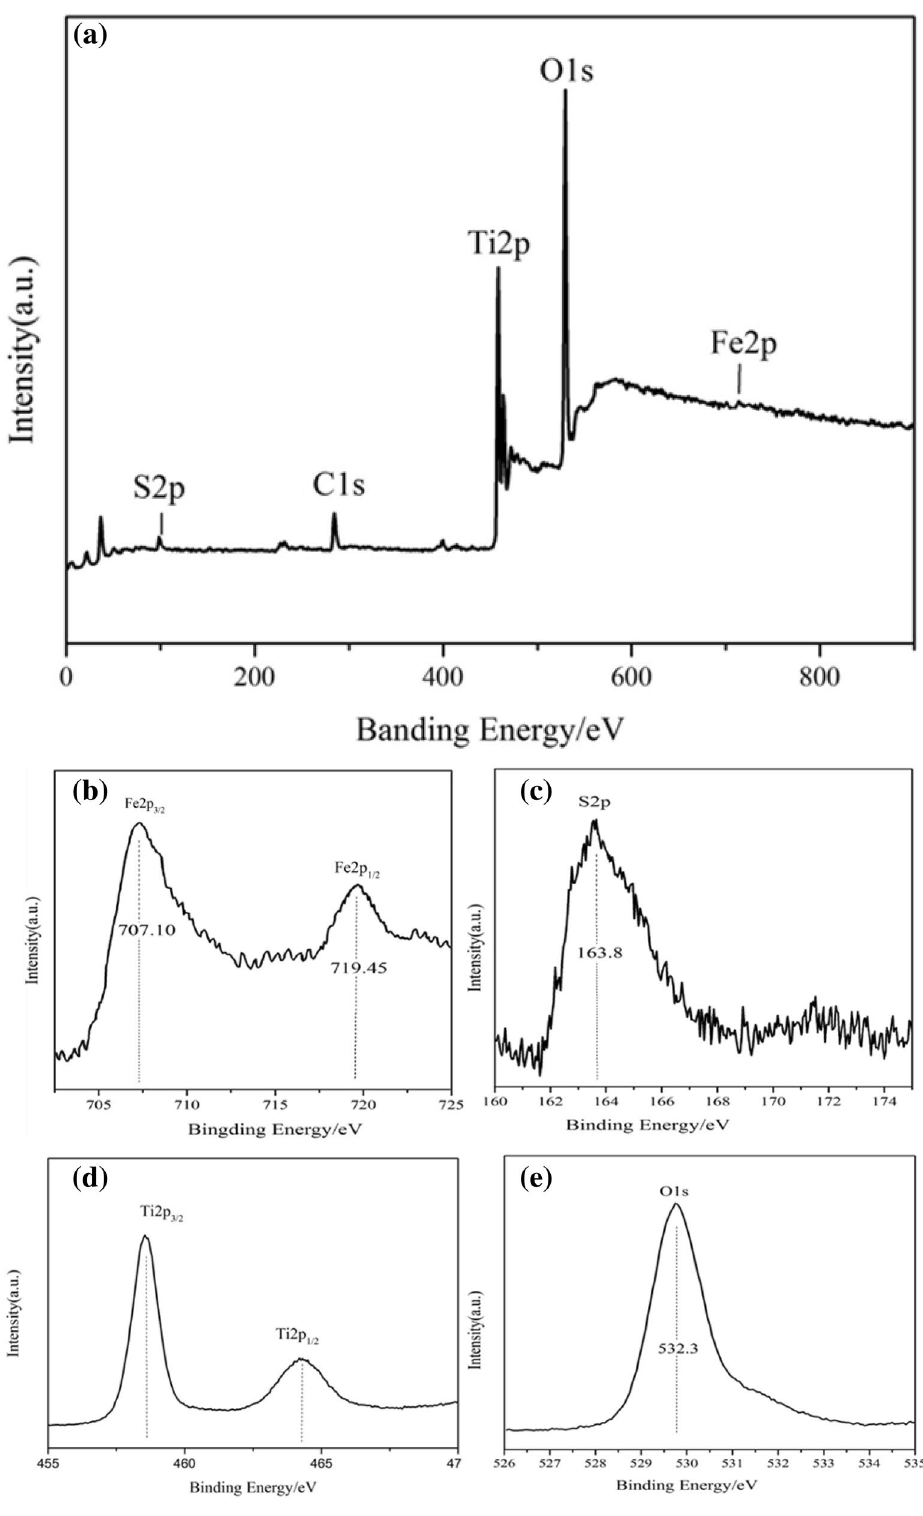
Figure 6. XPS survey spectra ( a ), Fe2p ( b ), S2p ( c ), Ti2p ( d ), O1s ( e ) core level spectrum of FeS 2 /TiO